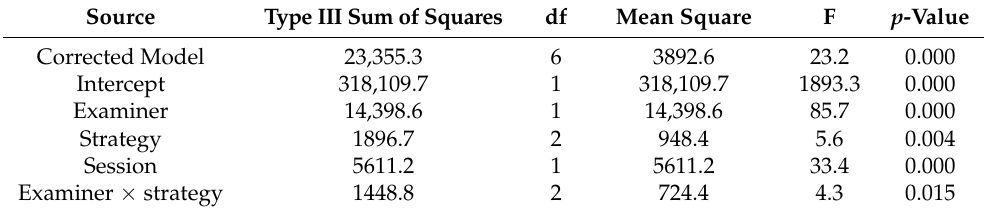
Table 4. Results tests of between-subjects effects of General Linear Model.